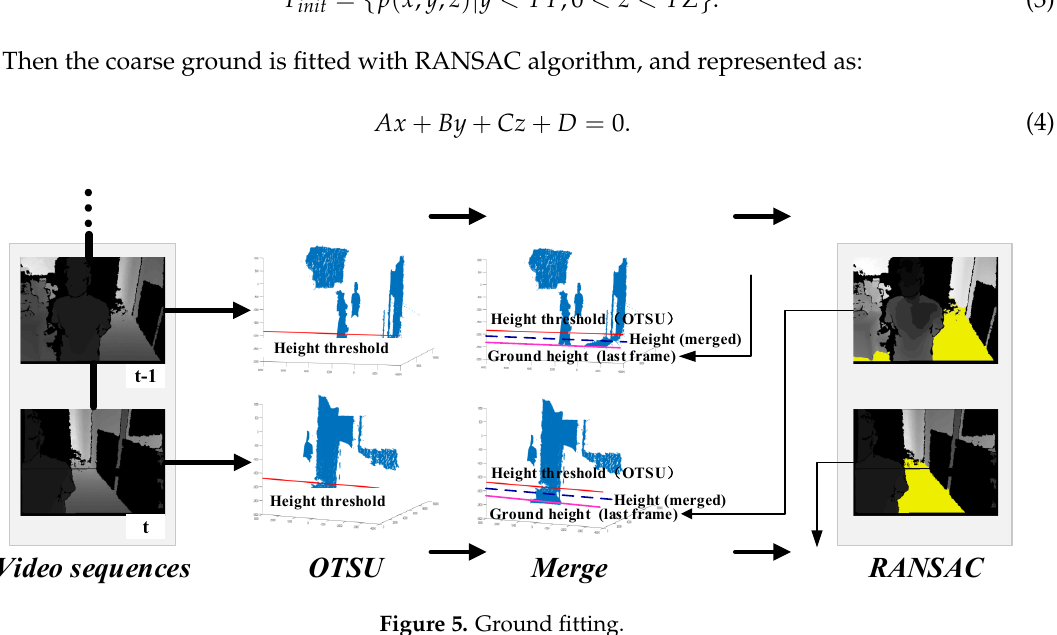
Figure 5. Ground